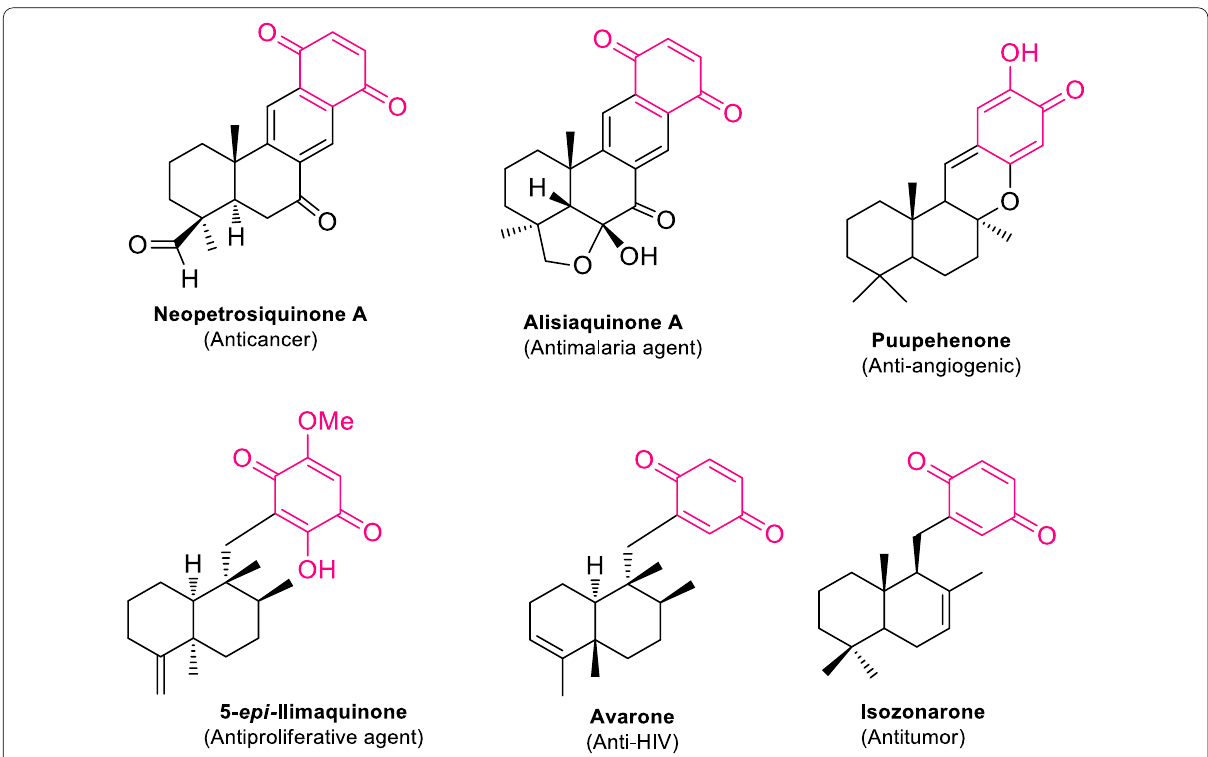
Fig. 2 Some examples of terpenoquinone articulate bioactive natural molecules [6,